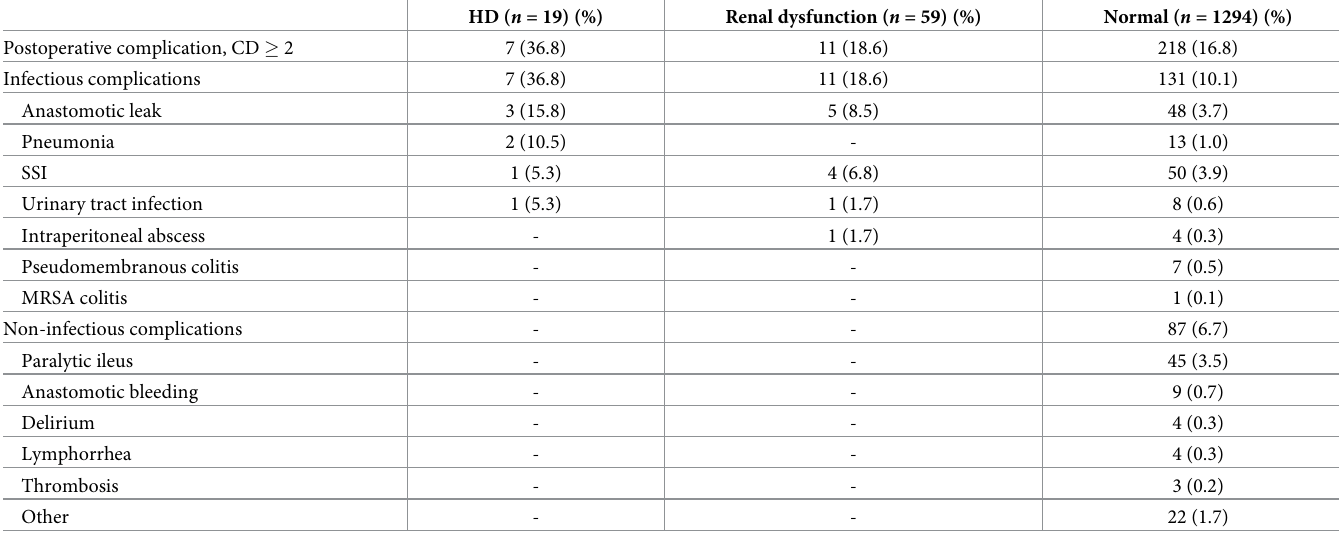
Table 3. Postoperative complications (CD �